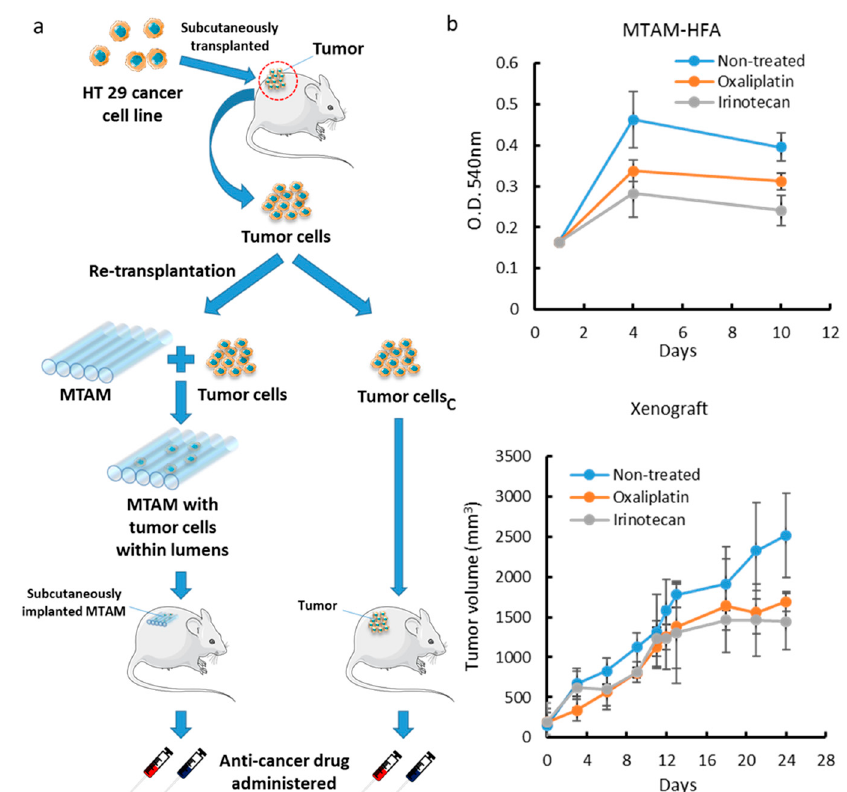
Figure 4. The Mouse PDX model was used to evaluate the reliability of MTAM PDX system ( a ) HT29 cancer cell line were injected into mouse model to establish a tumor, and this mice is treated as a ‘patient’. The resulting tumor were extracted and divided into two, where one part was utilized in the MTAM-based HFA system and the other in a standard xenograft model to serve as a benchmark. ( b ) Growth inhibition of primary HT29 cells in the MTAM implanted s.c. in mice. Drugs were administrated once daily by i.v. injection from days 3–7 after implantation. ( c ) Nude mice bearing 100 mm 3 xenografts were randomized into treatment groups, Tumor volume of mice bearing primary HT29 xenografts was measured every other day. Both ( b ) and ( c ) appeared to provide similar screening outcome trend and to a certain extent comparable outcome, which suggested that the MTAM PDX system was capable of producing similar outcome when compared to the current gold standard (traditional xenograft) Student’s t-test; P < 0.05.